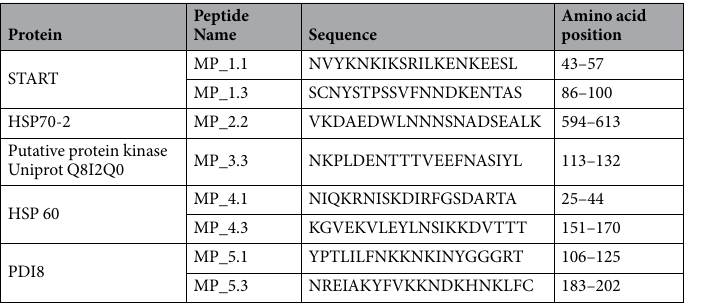
Table 2. Peptides selected for IgG immunoreactivity analysis with patients sera from Breman-Asikuma (adults and